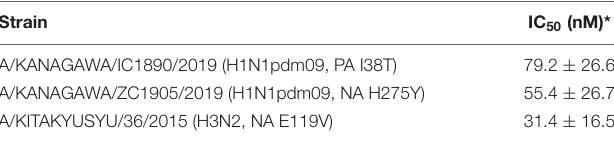
TABLE 3 | IC 50 of SMeFM for the propagation of influenza virus clinical isolates with low susceptibility to anti-influenza drugs. Strain IC 50